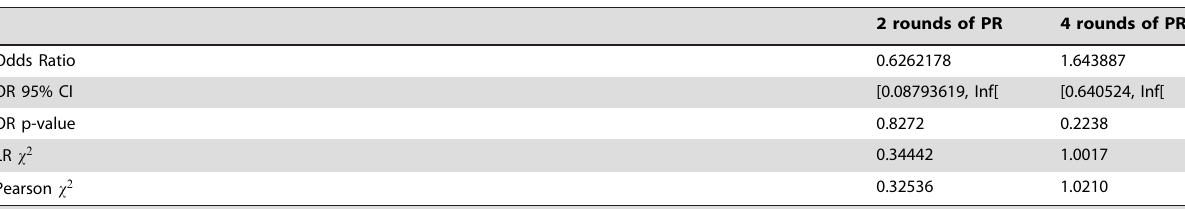
Utility Hypothesis: does PR cause students to find statistics more